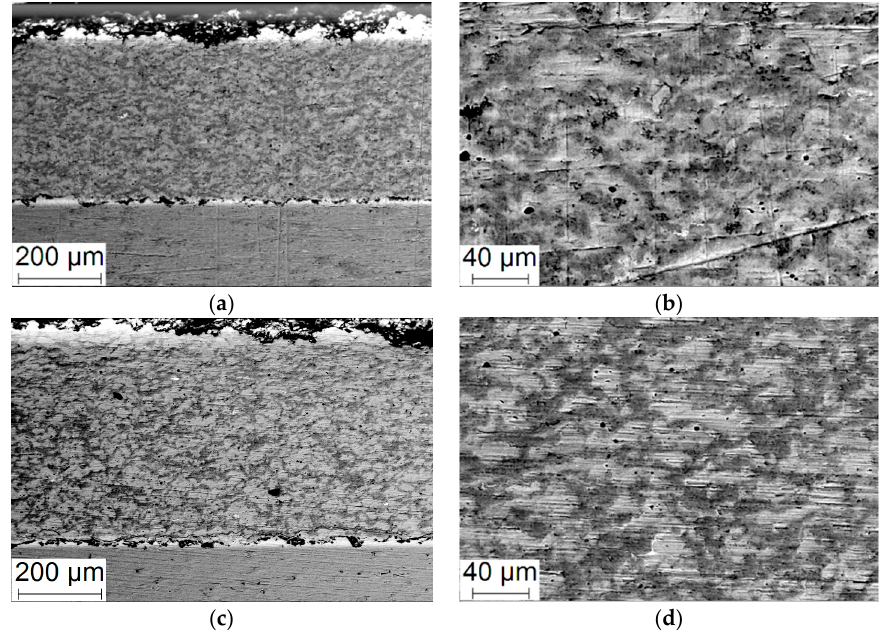
Figure 6. SEM-micrographs taken at the cross section of the specimens produced in regime No. 5 ( a , b ) and No. 6 ( c , d ).